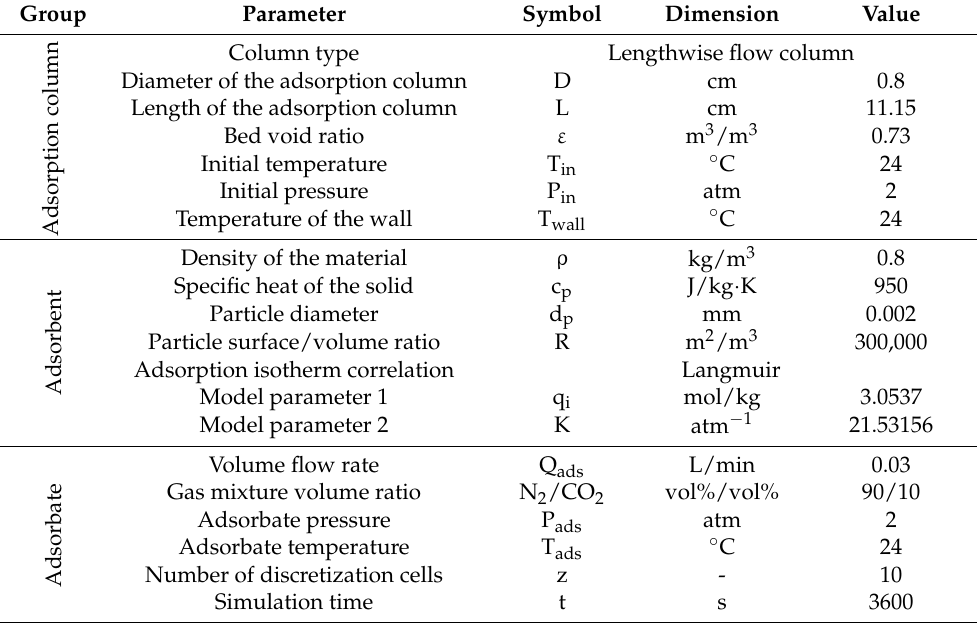
Table 3. Input parameters for dynamic simulation of TSA process in the CFAZ-CO 2